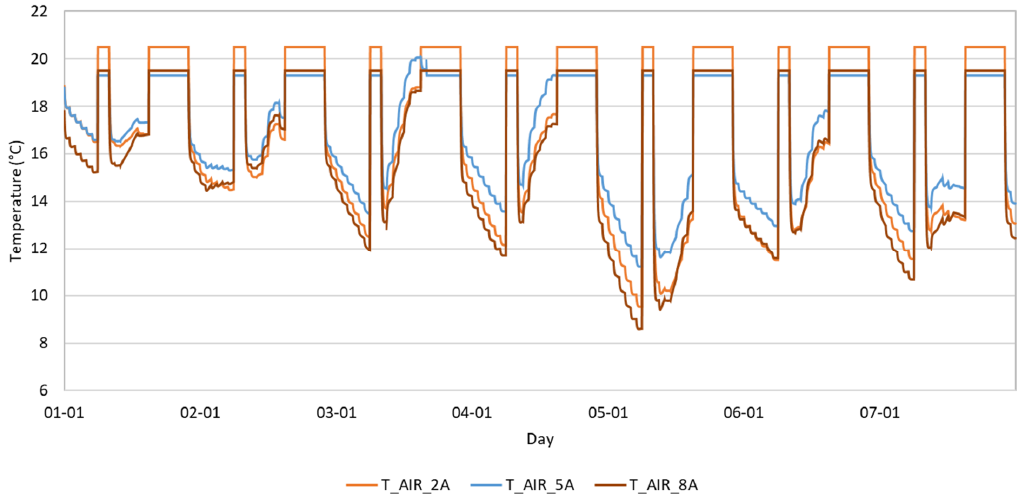
Figure 7. Simulated indoor temperature variation of apartments 2A, 5A and 8A in a representative week of the heating season, base scenario.